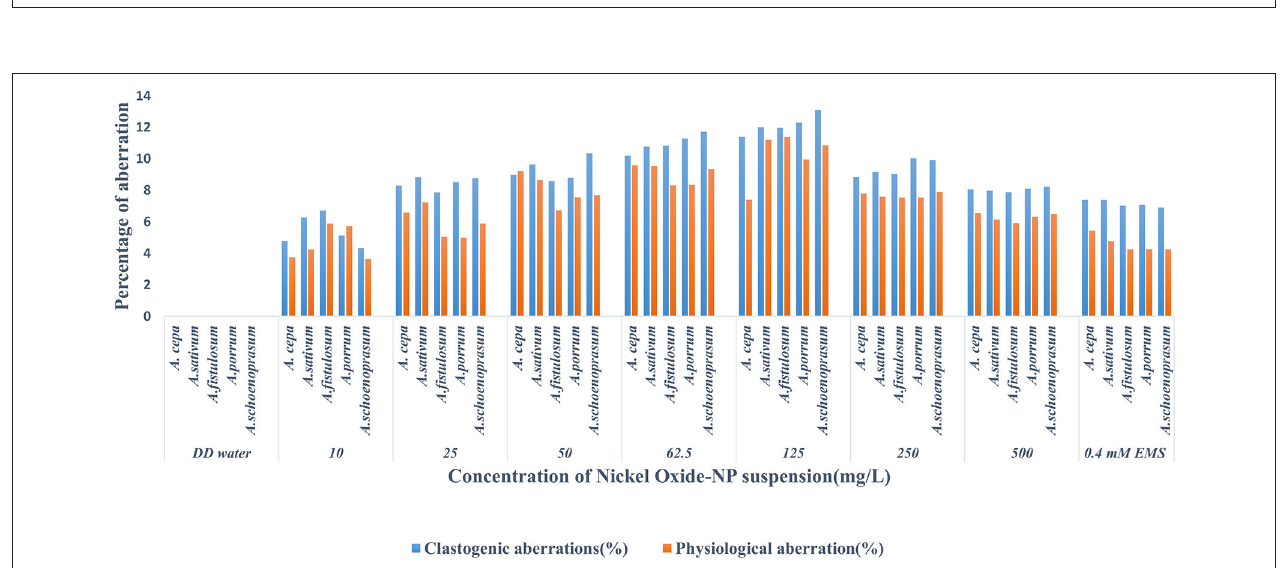
FIGURE 8 | Incidence of Clastogenic and Physiological aberrations on NiO-NP exposure in the five species of Allium.